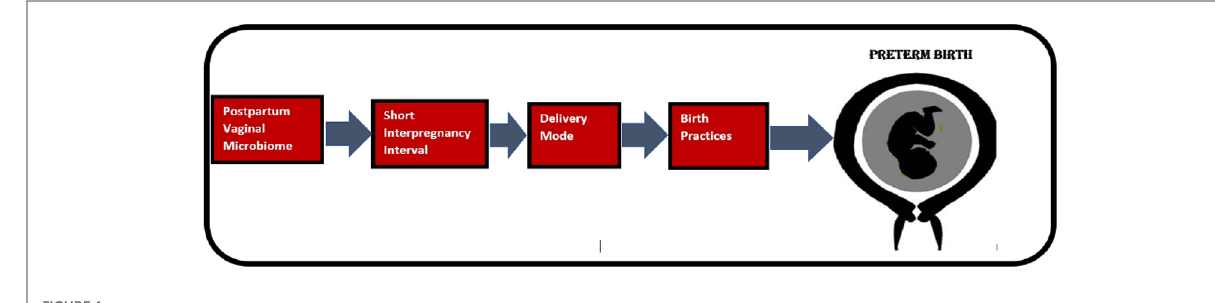
FIGURE 1 Causal chain diagram depicting some underlying factors that contribute to preterm